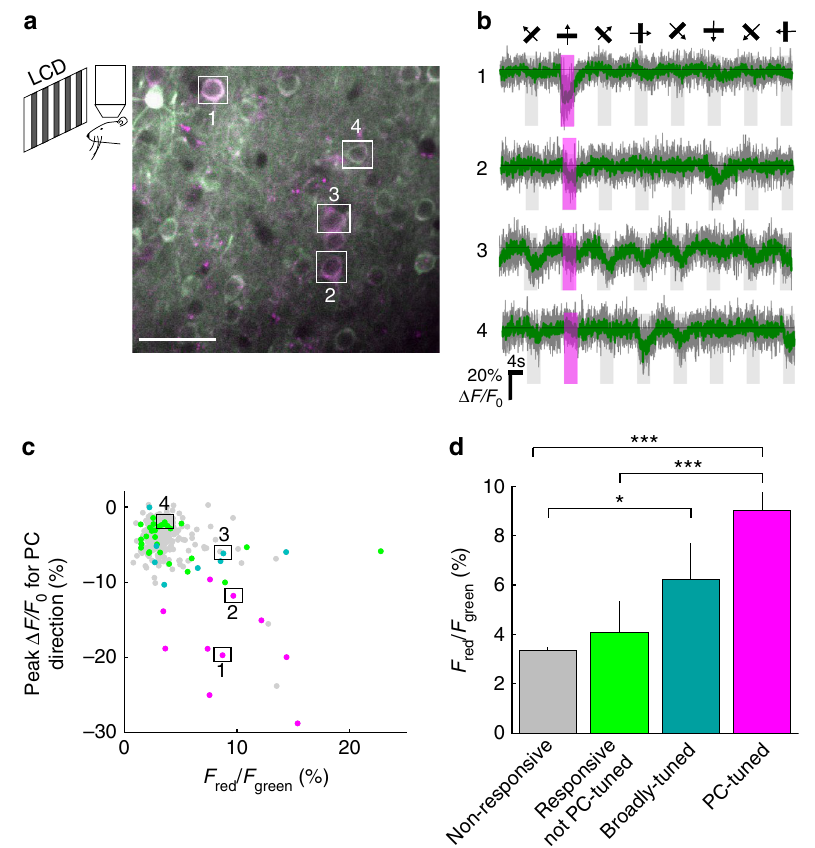
Fig. 4 CaMPARI2 activity and PC in mouse primary visual cortex. a Schematic of the experimental setup (left). Two-photon fl uorescence signal from cortical layer 2/3 neurons in V1 after PC (right). b Changes in fl uorescence signal from four example cells marked in a . Cell numbers 1 – 2 are PC-tuned and have high OSI (0.8 and 0.92, respectively), cell number 3 is responsive and broadly tuned (OSI = 0.22), and cell number 4 is responsive and not PC-tuned (OSI = 0.96). c Correlation between peak Δ F / F 0 for the northward moving grating stimulus and the red-to-green ratio for individual responsive cells expressing CaMPARI2. Cells were grouped into four categories: non-responsive (not signi fi cantly responsive cells, gray dots), broadly tuned (signi fi cantly responsive and OSI < 0.5, cyan), PC-tuned (OSI > 0.5 and signi fi cant response to northward moving grating stimulus, magenta), and not PC-tuned